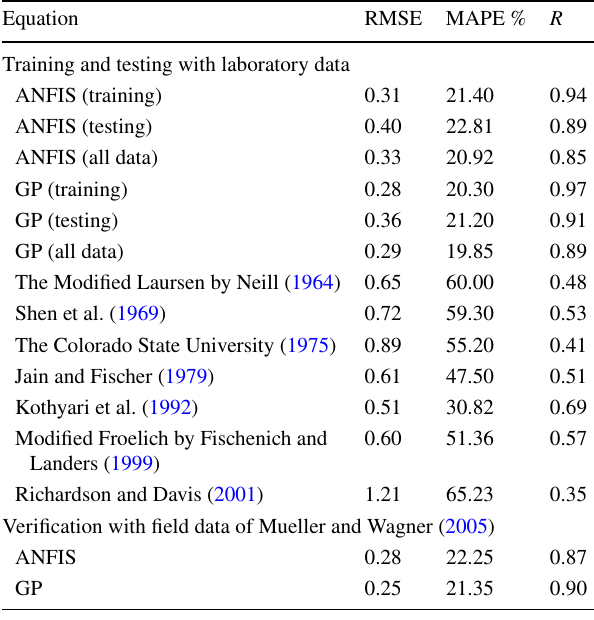
Fig. 10 ANFIS- and GP-predicted values of d and Davis (2001)